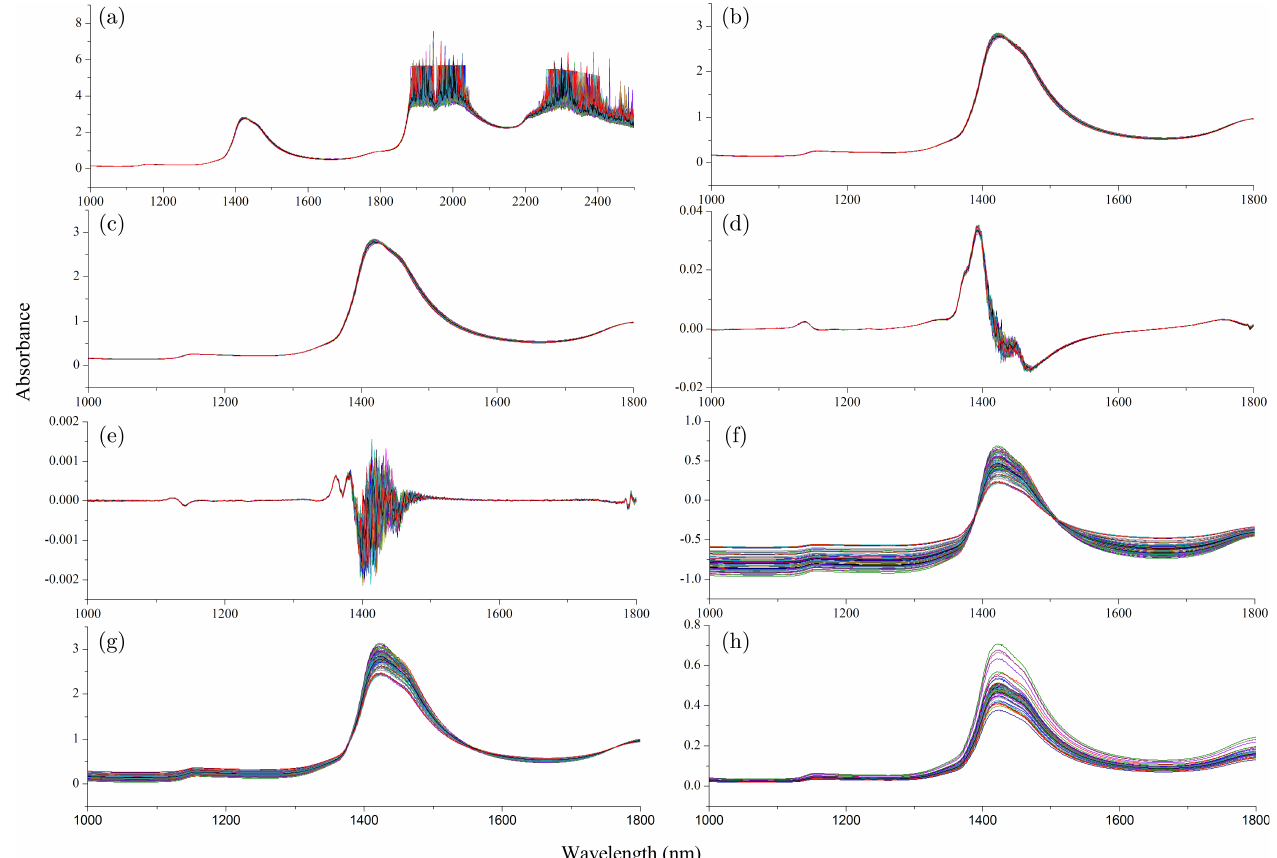
the calibration and prediction sets are listed in Table 3. The calibration set ranges covered the larger scale and the concentrations were evenly distributed in both data sets.